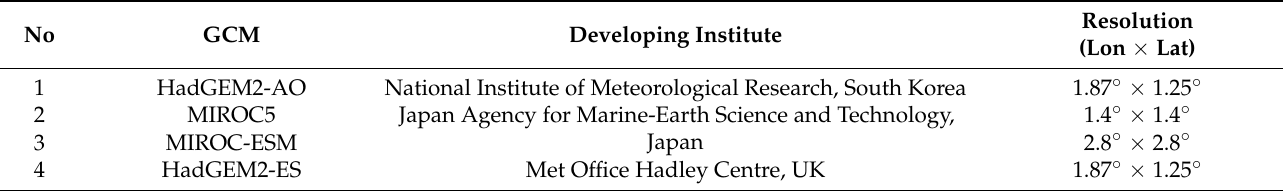
Table 1. Description of the global climate model employed in this